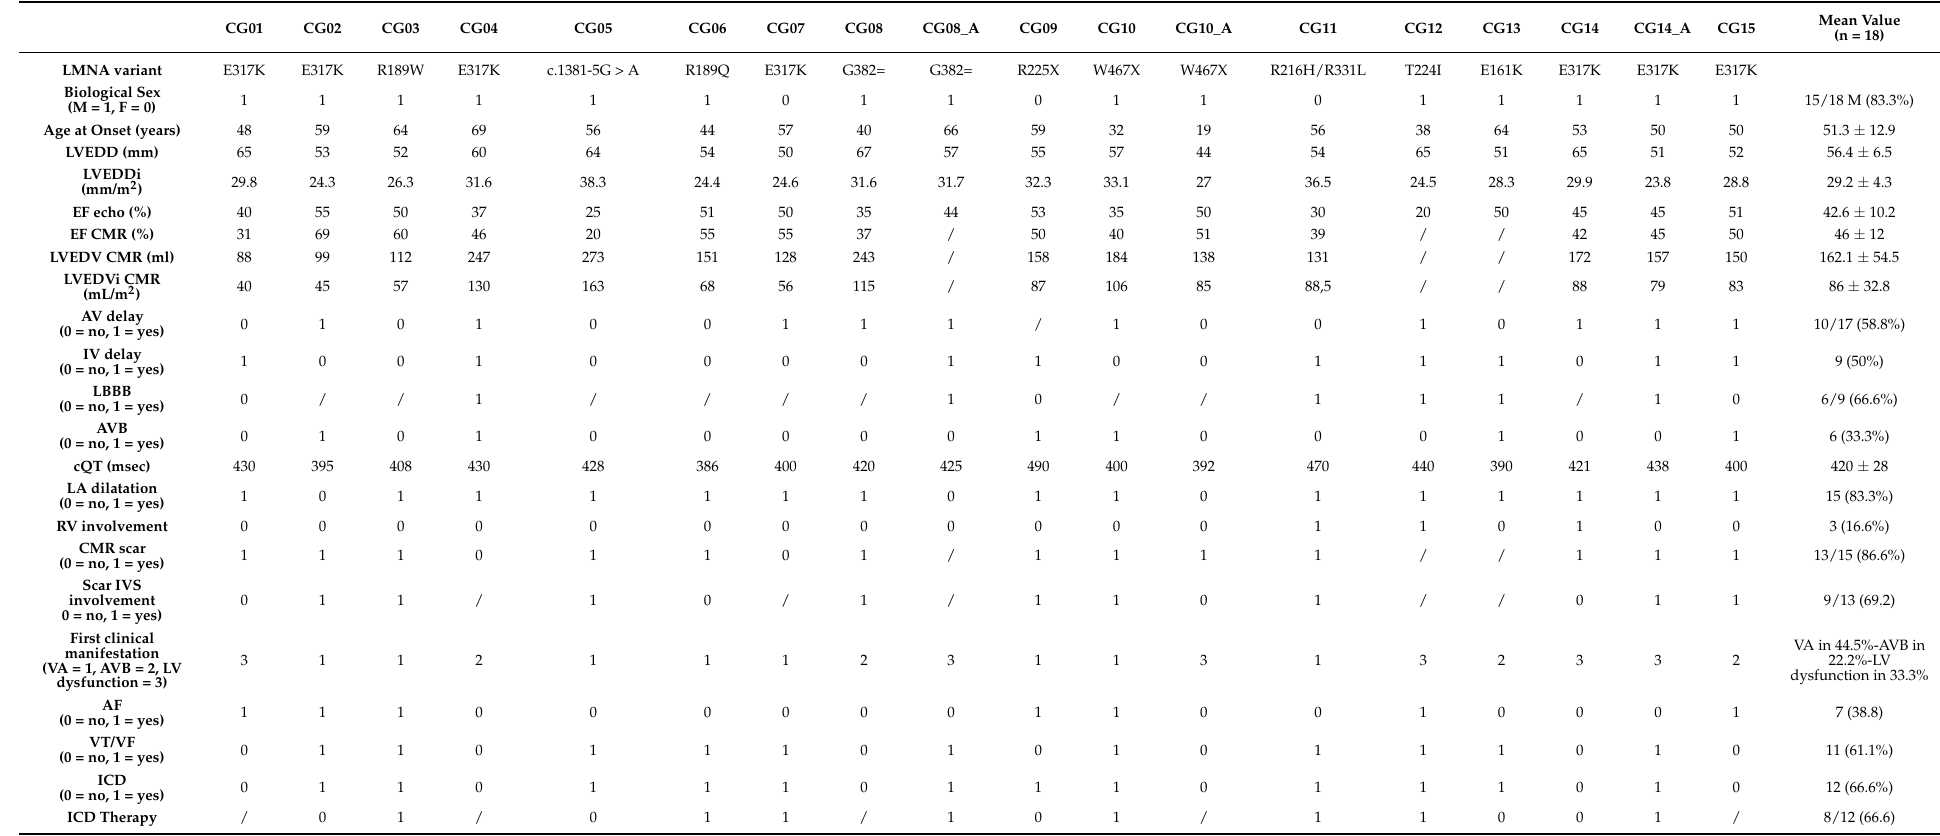
Table 3. DCM clinical